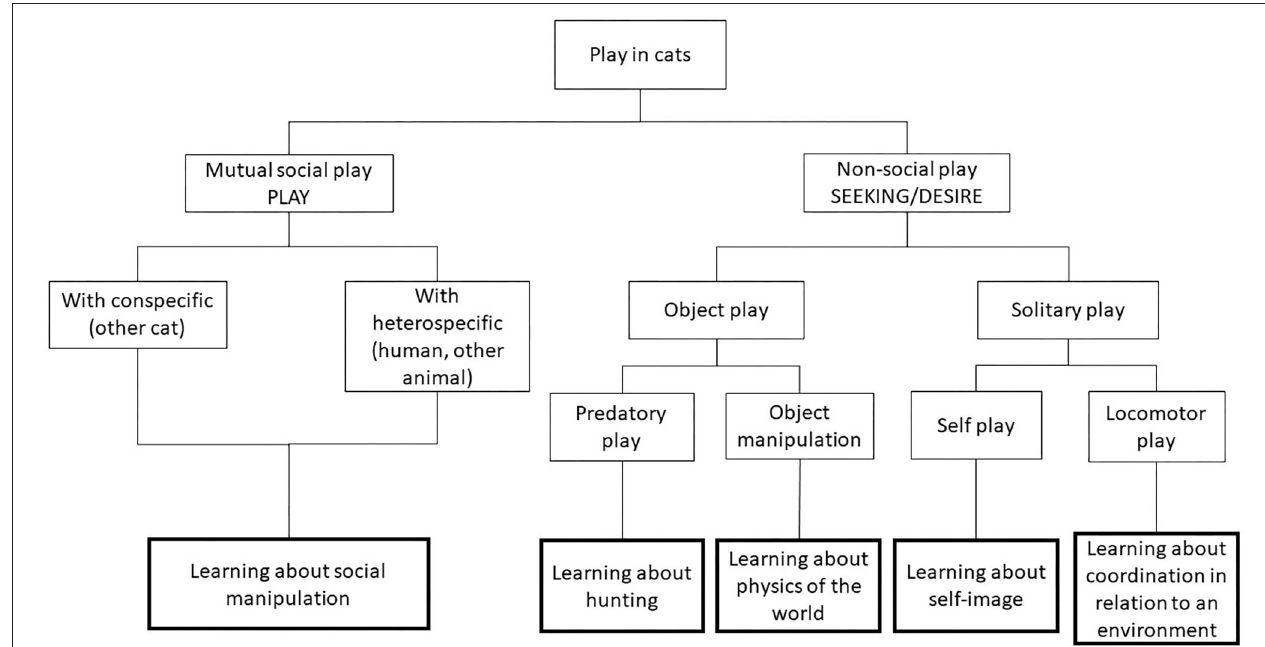
FIGURE 1 | Proposed psychobiological classification of play in cats. At the first level the affective (psychological) basis to the type of behaviour involving play is distinguished using the terminology of Panksepp (20). The lowest level represents the specific functional (biological motivational) goals of specific types of action, several of which may be related to a given affective